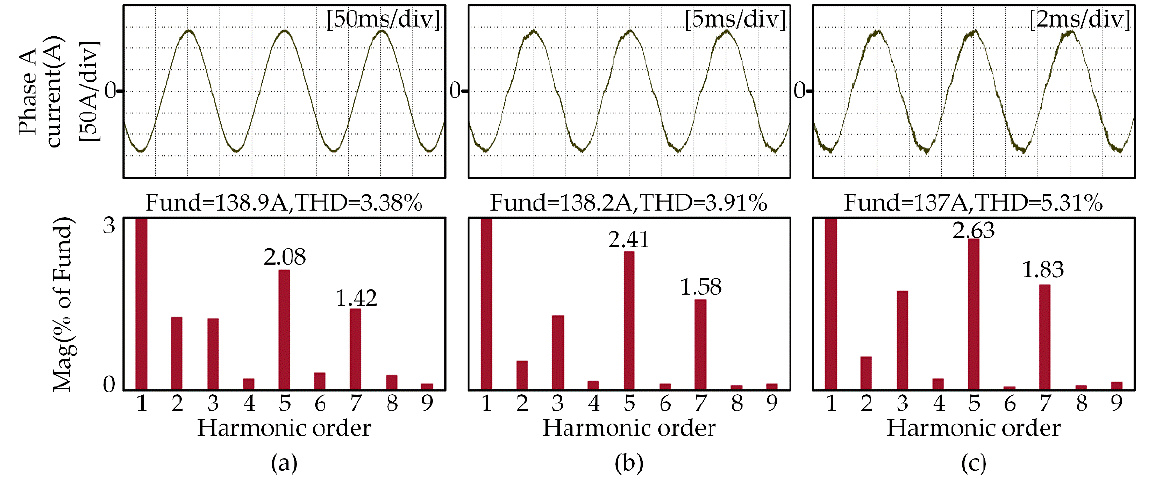
Figure 16. Waveforms of phase A current and its FFT analysis results without current harmonic suppression strategy applied. ( a ) 100 rpm; ( b ) 1000 rpm; and ( c ) 2500 rpm.